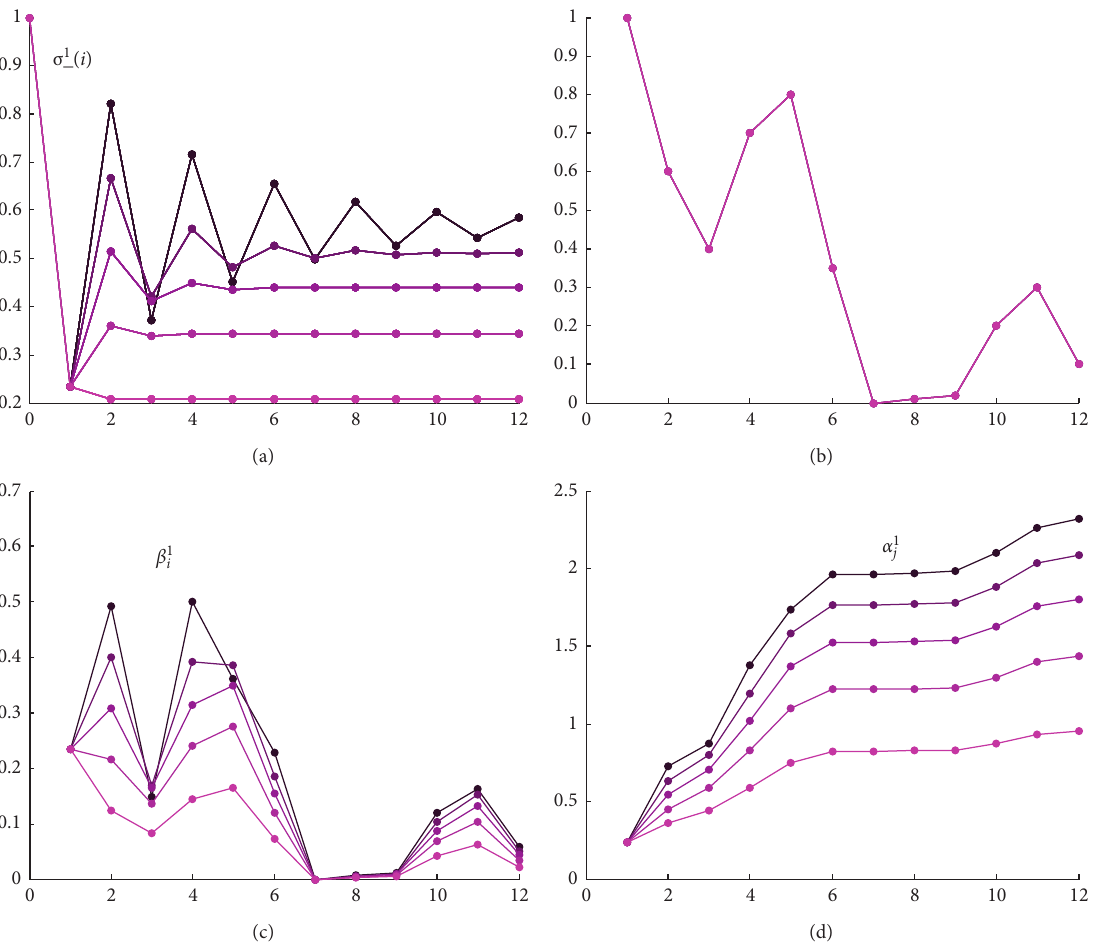
Figure 3: Simulation of five scenarios for 12 months. The union of the values by lines is only for tracking purposes. (a) Values of σ period of twelve months; (b) factor of proportion ξ i ; (c) β i for five probable states of loss of control; (d) accumulation factor α j .